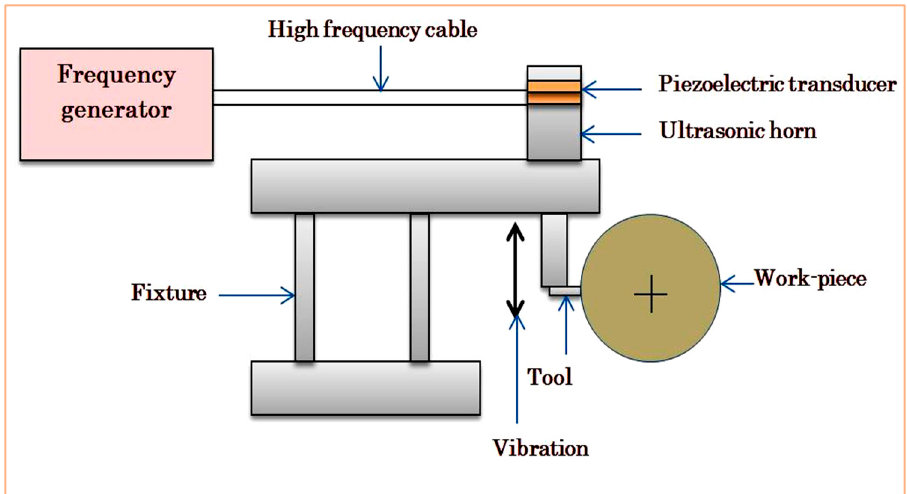
Figure 1. Schematic of ultrasonically assisted turning set-up.